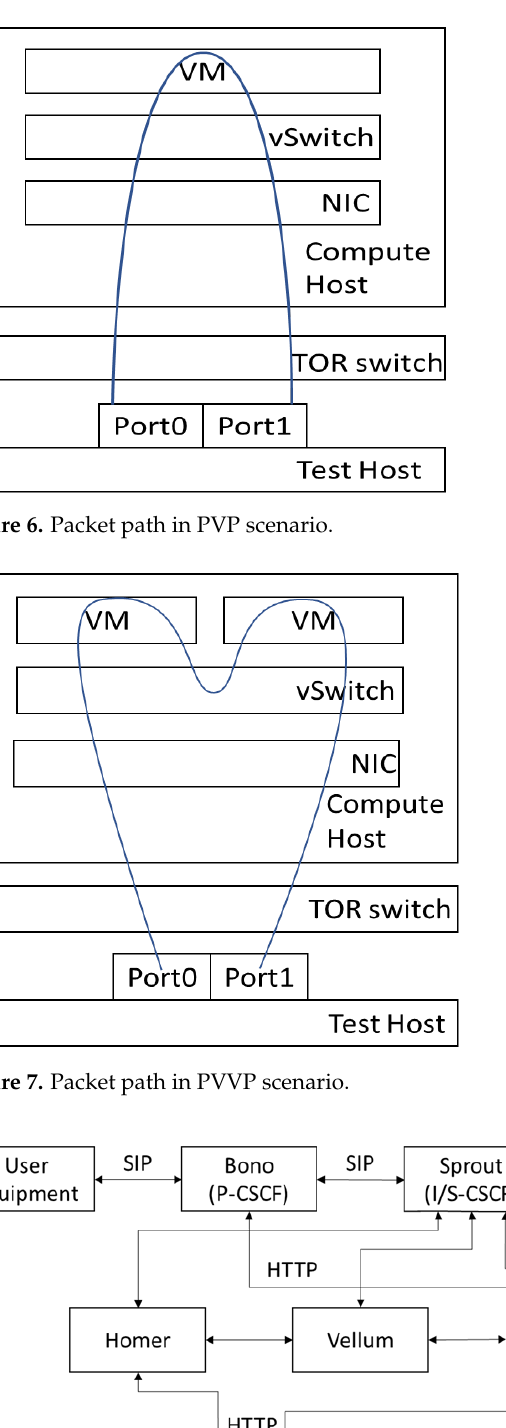
Figure 8. Architecture of Clearwater vIMS.